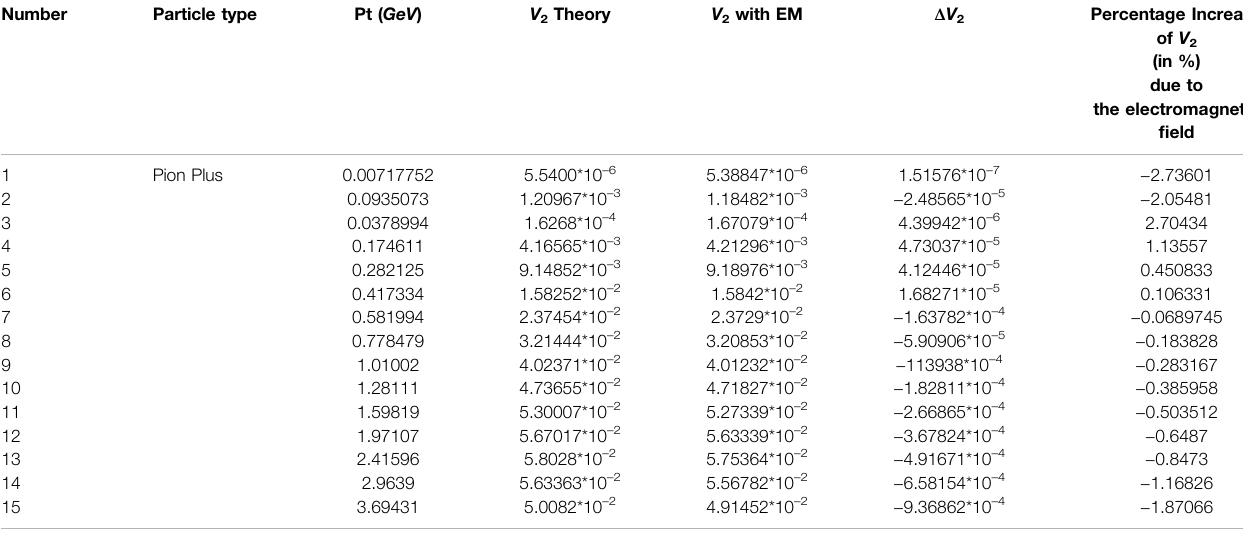
TABLE 2 | The percentage increase of elliptic fl ow of Pion-Plus due to the electromagnetic force evolution created in relativistic Pb + Pb collision with collision energy of (cid:4) √ (cid:1) 2.76 ATeVatcentrality rangingfrom20to30%(impactparametersintherange6.24 fm < b < 9.05 fm).Thechangeinelliptic fl ow( Δ V s V 2 theory and V 2 with EM.